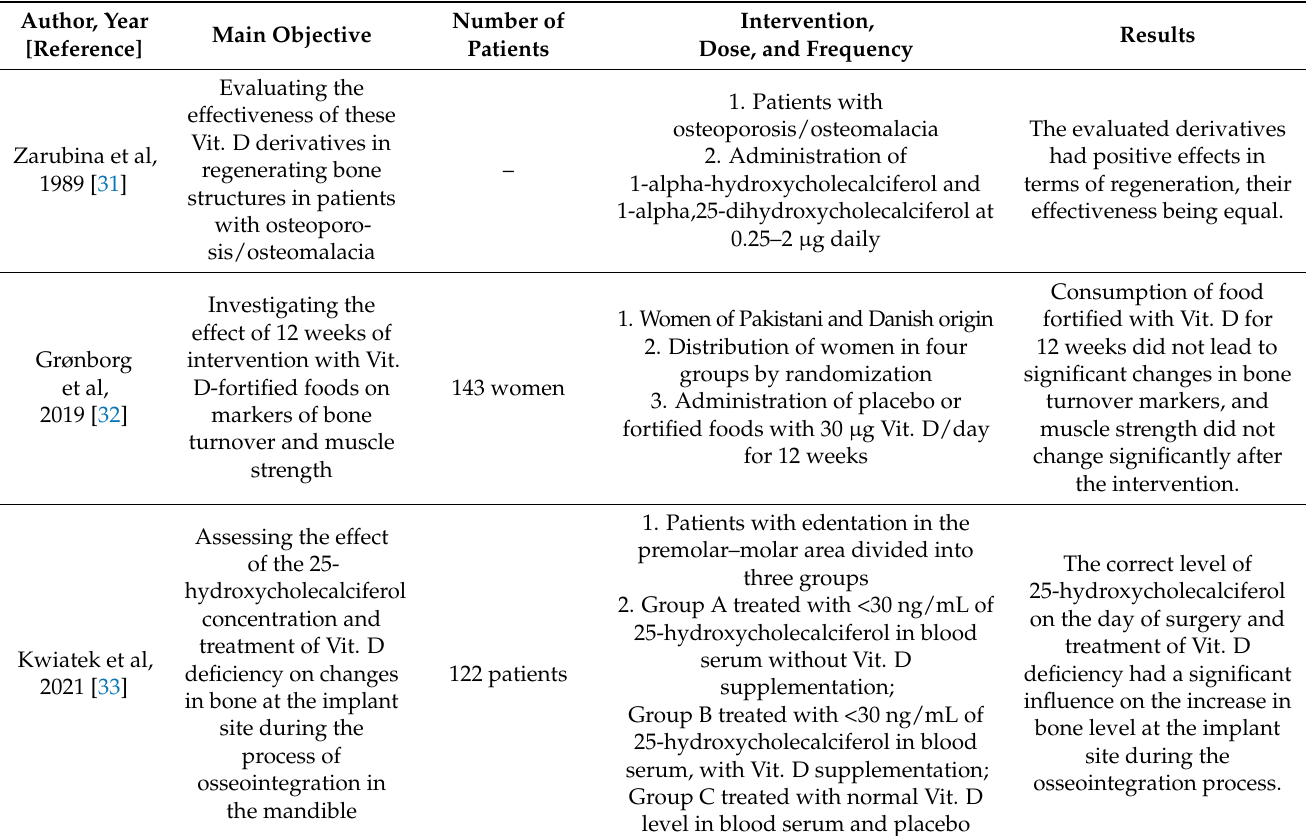
Table 4. Characteristics of the studies on patients and their